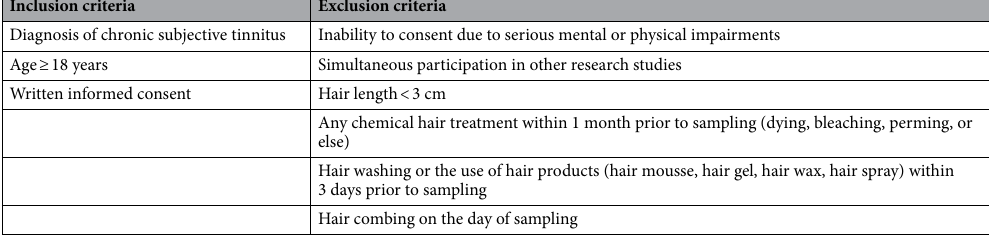
Table 1. Inclusion and exclusion